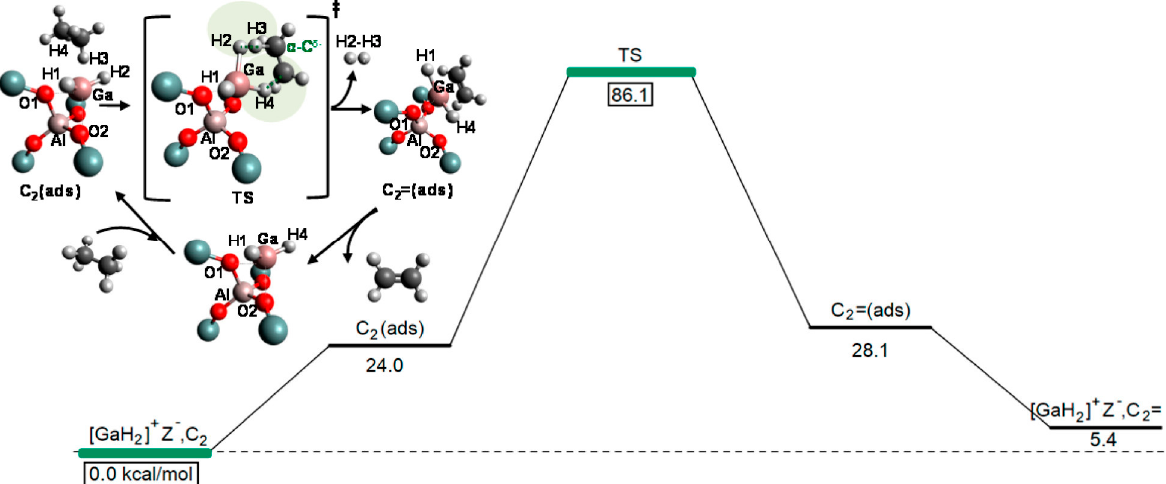
Molecules 2021 , 26 , x FOR PEER REVIEW 22 of 28 Figure 28. Ethane dehydrogenation via the concerted mechanism on [GaH 2 ] + and the corresponding free energy surface (kcal/mol) reported at 823 K and 1 atm. Reprinted with permission from ref [94]. Copyright 2018 American Chemical Society.